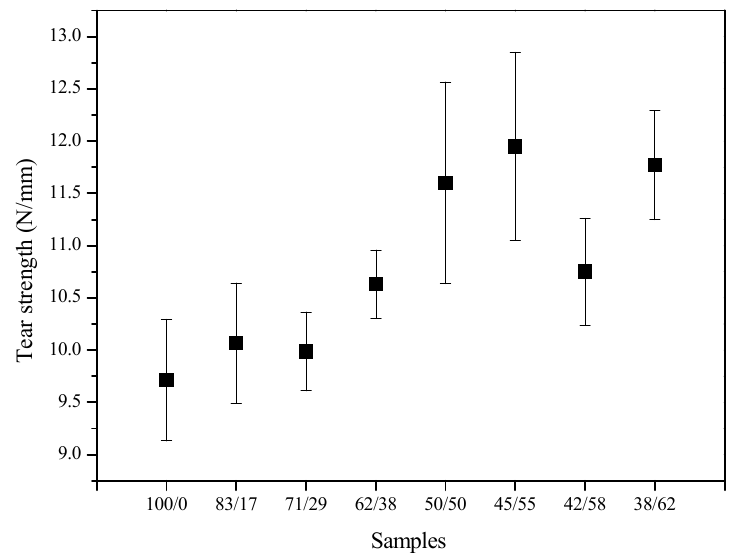
Figure 5. Tear strength of the analyzed blends.